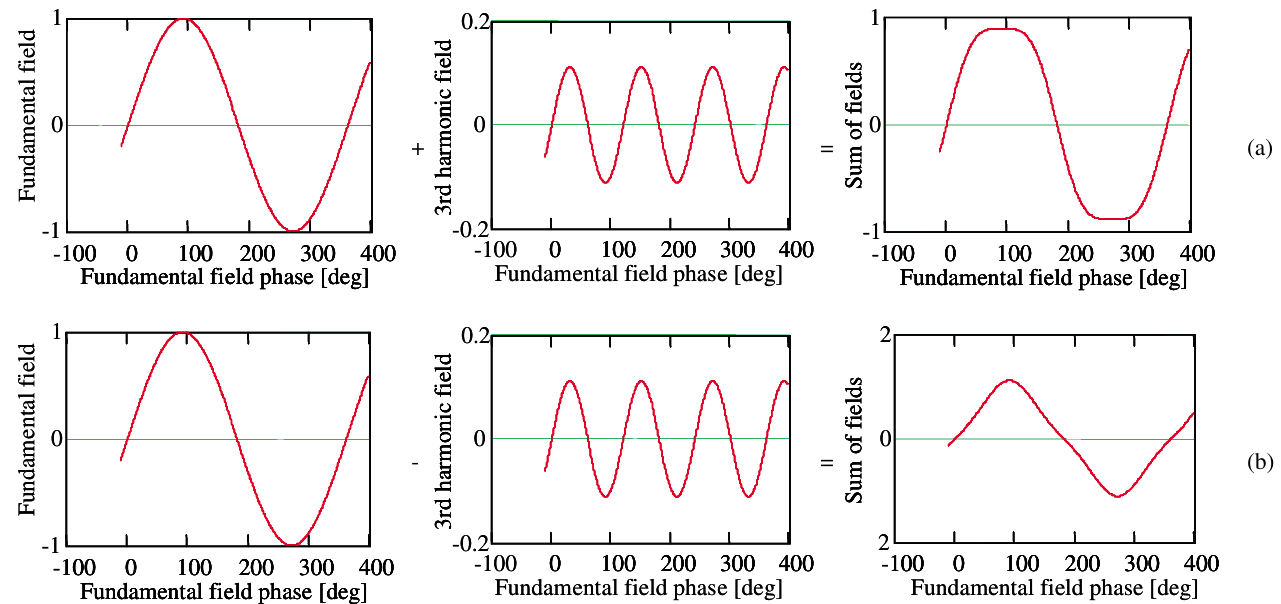
FIG. 5. (Color) Addition (a) and subtraction (b) of fundamental and 3rd-harmonic fields.